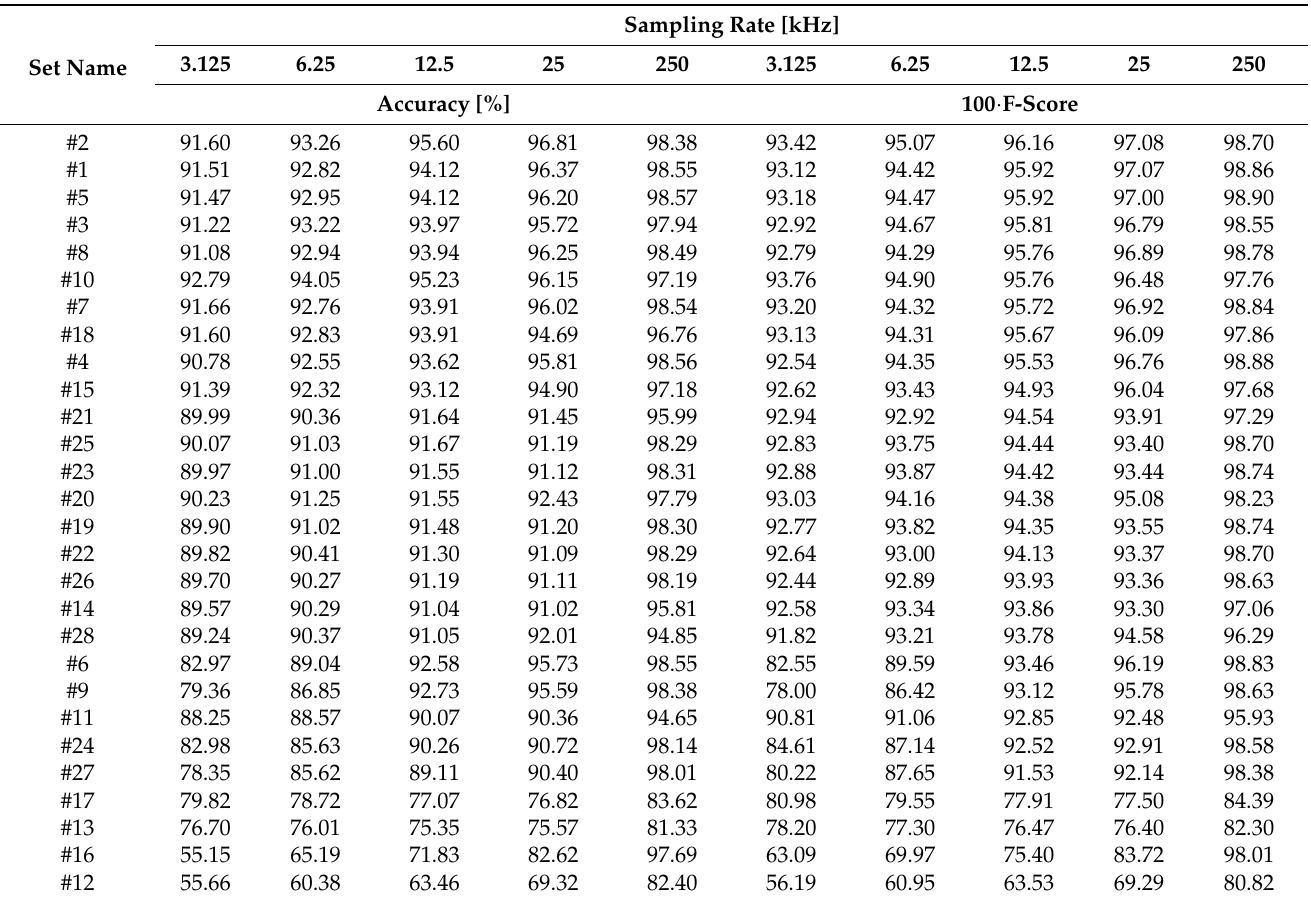
Table 4. Arc fault detection results for single cycle analysis, sorted by F-score for 12.5 kHz sampling